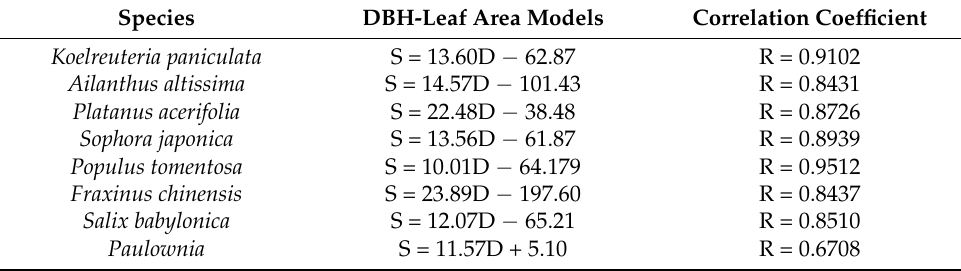
Table 2. DBH-leaf area models of broad-leaved